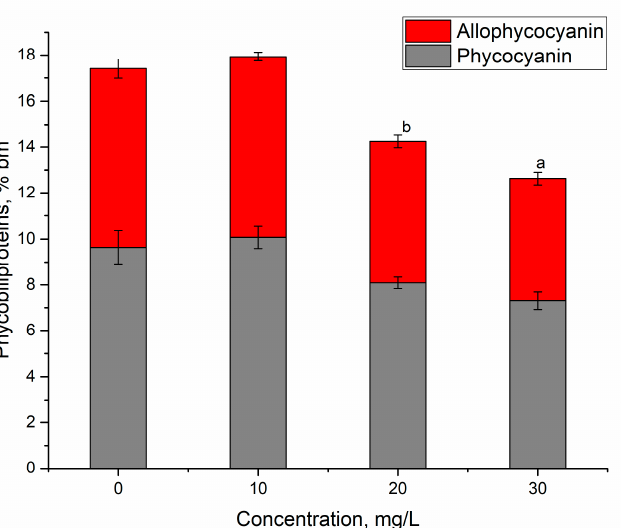
Figure 5. The content of phycobiliproteins in the biomass of Arthrospira platensis exposed to Y(III) in a concentration of 10–30 mg/L (a— p < 0.005, b— p < 0.01, for the difference between the sample and the control—the content of phycobiliproteins).